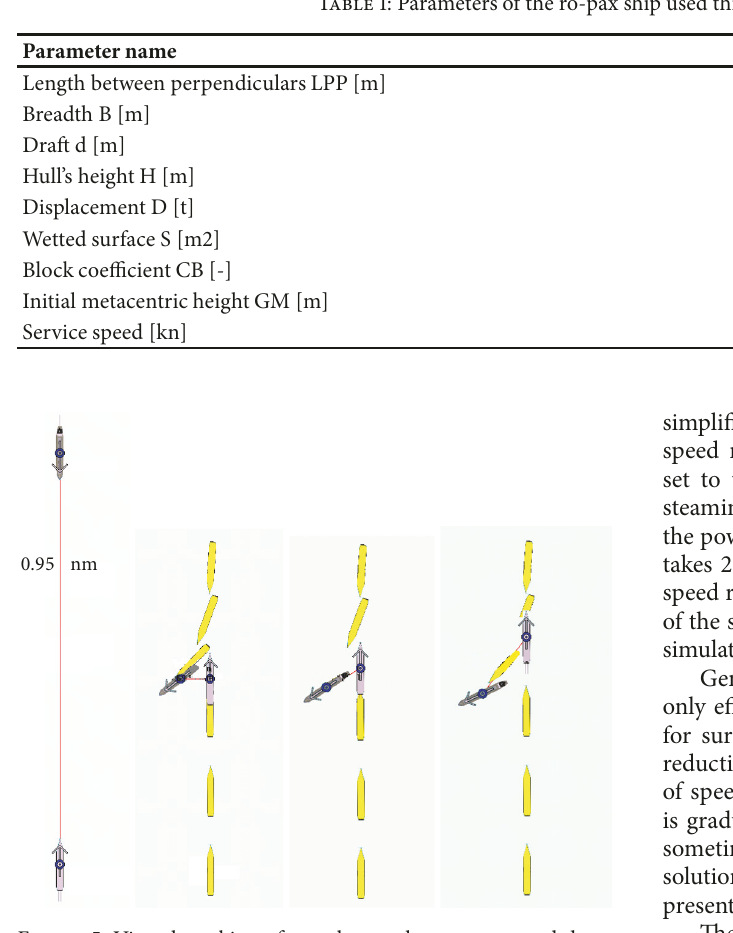
Figure 5: Virtual tracking of sample vessels encounter and deter- mination of the critical distance performed with the use of the full mission bridge